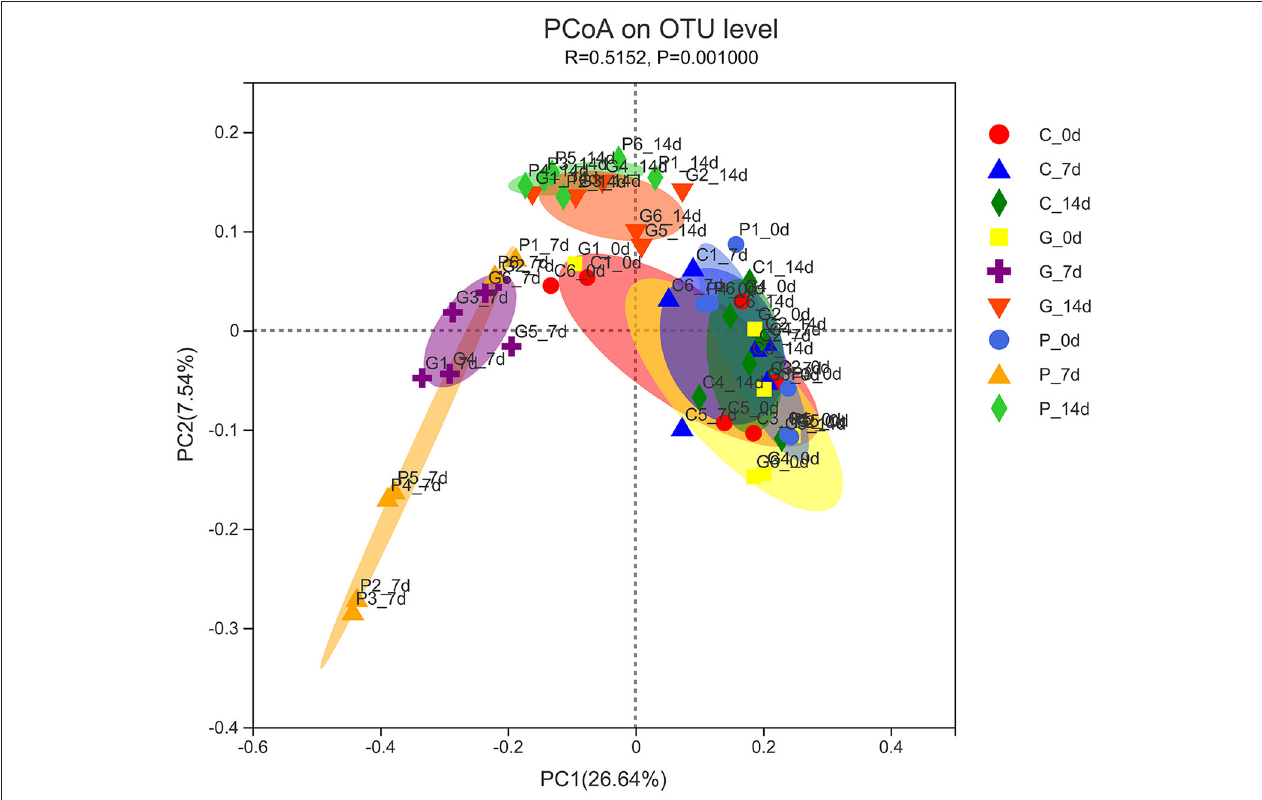
FIGURE 2 | PCoA analysis of experimental groups. C_0 d, 7 d, 14 d represent the samples of the control group on 0 d, 7 d, 14 d, respectively; G_0 d, 7 d,14 d symbolize the samples of chlortetracycline rumen-protected granules group on 0 d, 7 d, 14 d, respectively; P_0 d, 7 d,14 d represent the samples of chlortetracycline premix group on 0 d, 7 d, 14 d, respectively. The horizontal and vertical axes represent the first and second principal coordinates explaining the most significant proportion of variance to the bacterial communities (showed by percentage). PCoA, principal coordinates analysis.